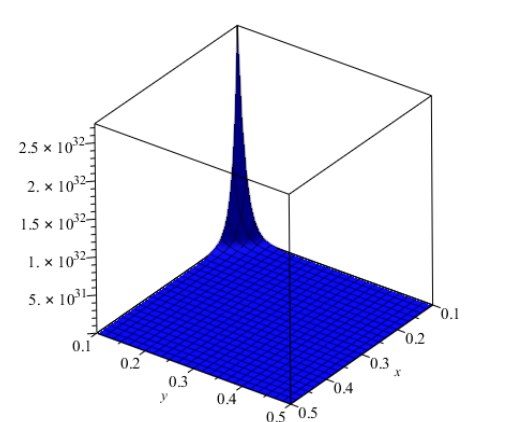
Figure 3: Graphical Representation of Forgotten polynomial of hex-derive network HDN 1( n )